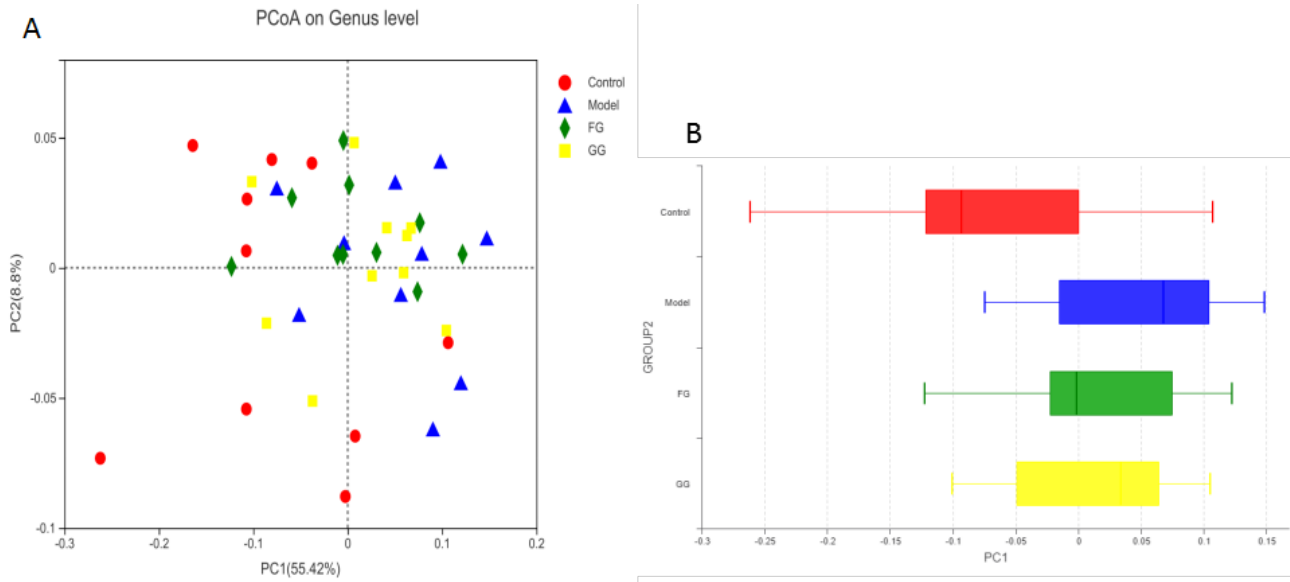
Figure 14. ( A ) PCoA analysis of the cecal microflora in db/db mice based on the weighted-unifrac distance ( n = 10); ( B ) the distribution of different groups of samples on the PC1